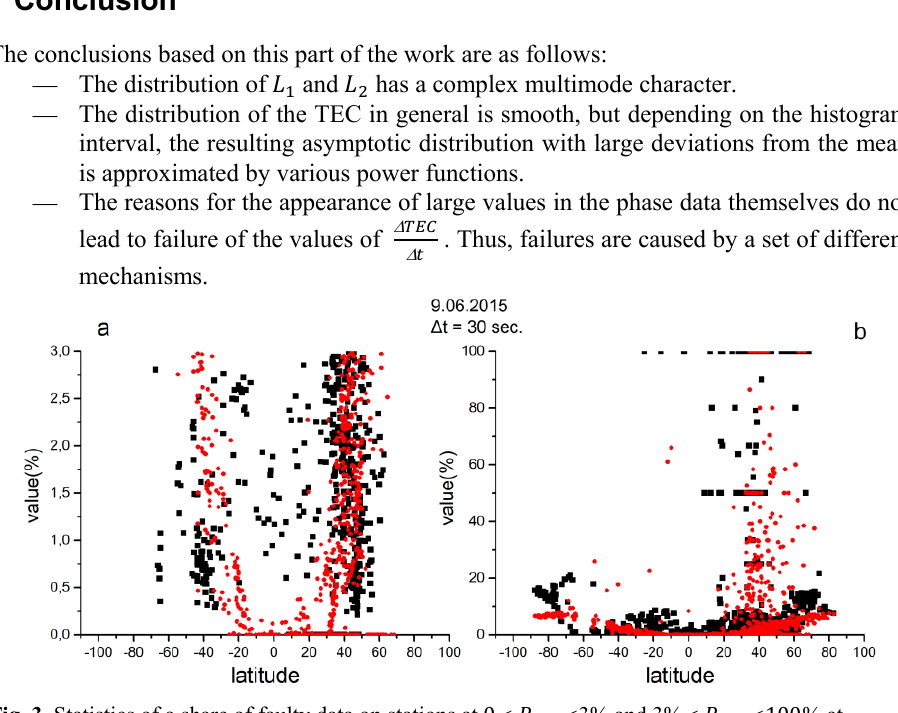
Fig. 3. Statistics of a share of faulty data on stations at 3% and 3% % at 9.06.2015.  - failures of data on a derivative and - - failures of data on a derivative